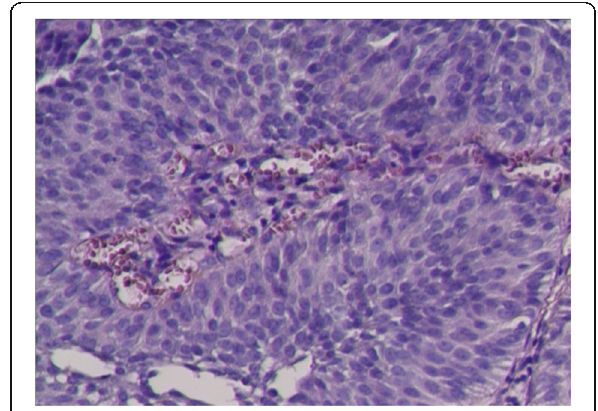
Fig. 1 Pathological examination. A 59-year-old male complaint of gross hematuria for 6 days. Transurethral resection of bladder tumor (TURBT) was performed. Histology shows typical morphology of bladder urothelial